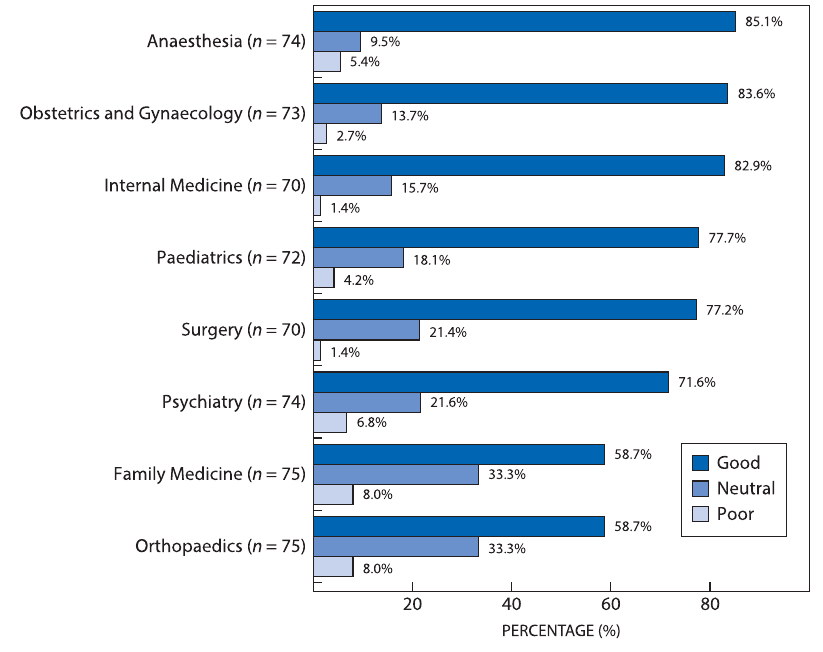
Figure 2: Ratings of different domains according to education, training, supervision, support and